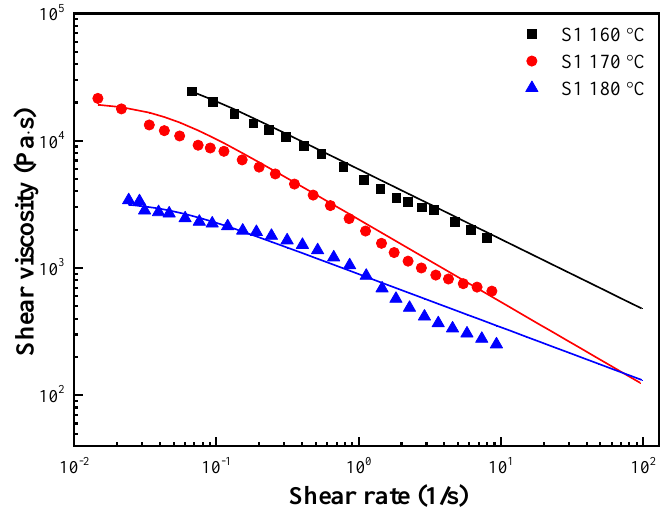
Figure 6. Shear viscosity as a function of the shear rate for S1 at various temperatures. The solid lines were fitted using the Carreau model. Table 2. Fitting parameters of the Carreau model for S1 under various temperatures.